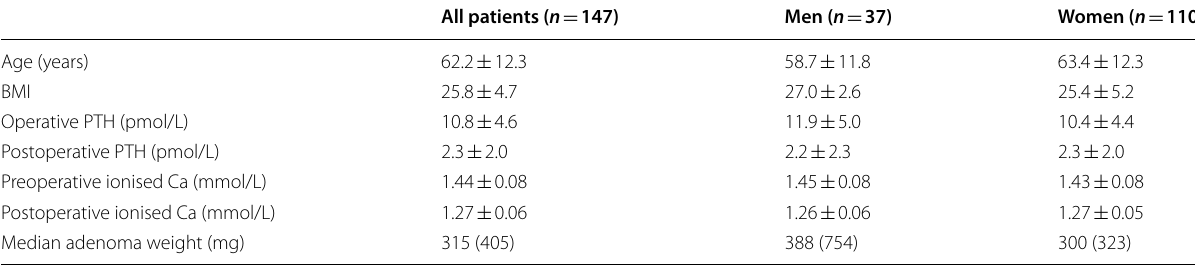
Table 1 Patient